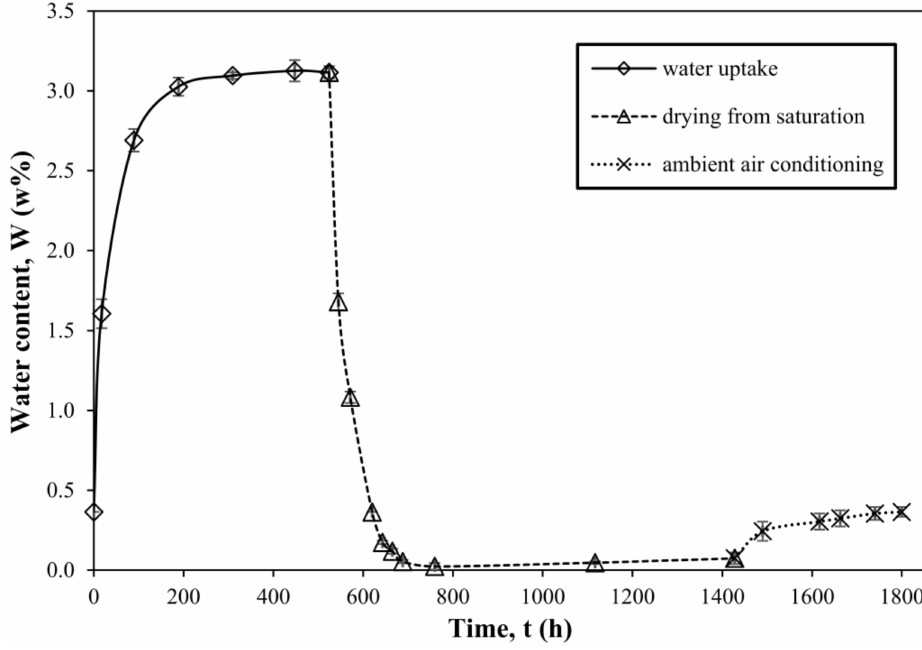
Figure 1. Water uptake, drying and conditioning in air curves of amine-cured epoxy